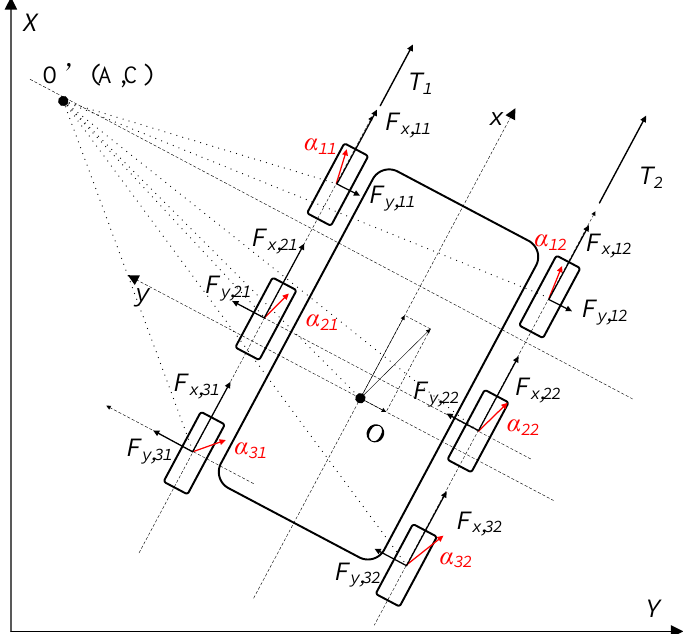
Figure 2. Force analysis for 3-DOF dynamics model.